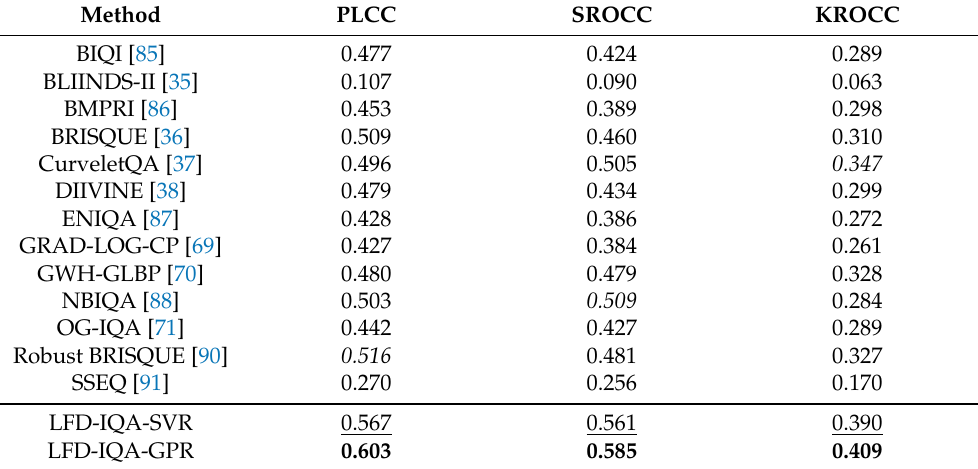
Table 8. Results of the cross database test. The examined and the proposed methods were trained on KonIQ-10k [22] and tested on CLIVE [21]. The best results are typed in bold, the second best results are underlined, and the third best results are typed in